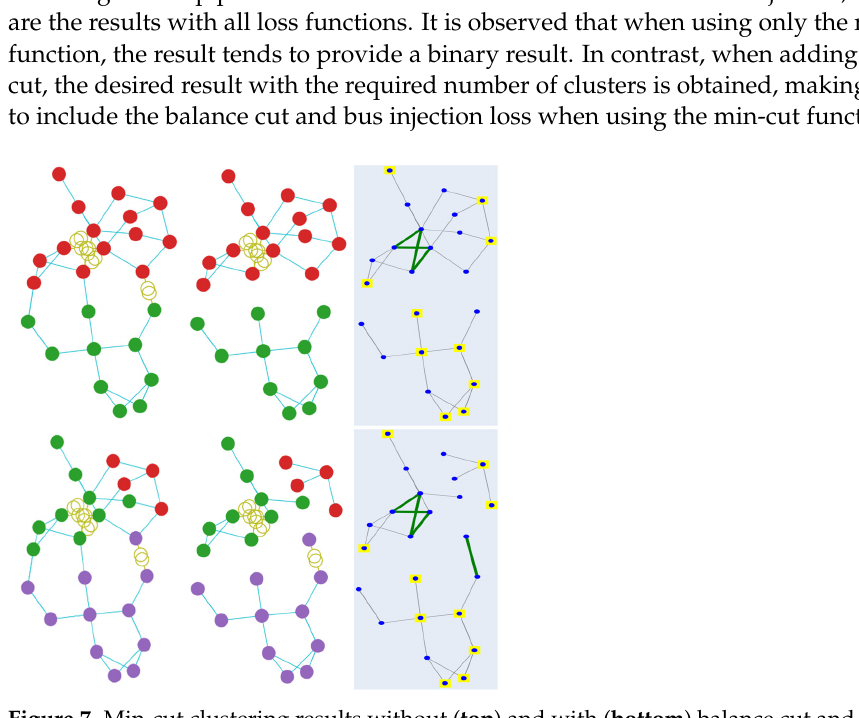
Figure 7. Min-cut clustering results without ( top ) and with ( bottom ) balance cut and bus injection loss